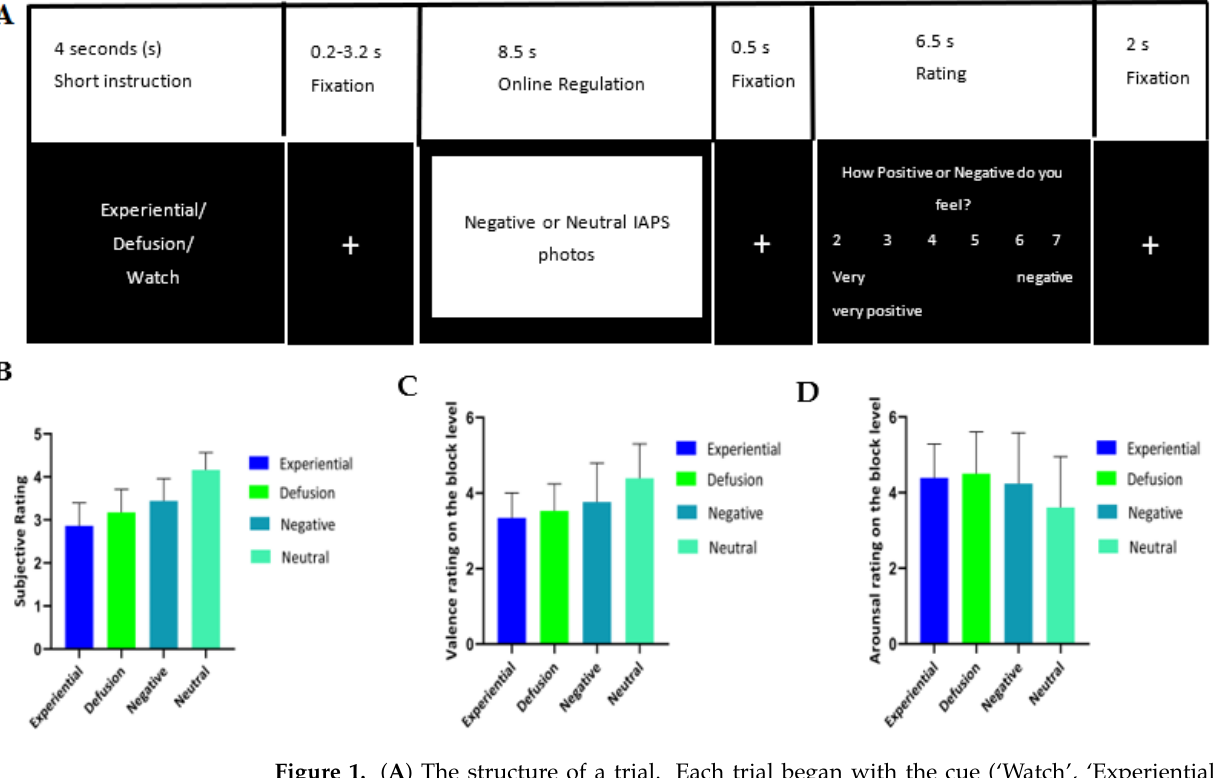
Figure 1. ( A ) The structure of a trial. Each trial began with the cue (‘Watch’, ‘Experiential’, or ‘Defusion’) for each stimulus. Each cue was displayed for 4 s, followed by a 0.2–3.2 s (jittered) interstimulus interval with a white cross and an 8.5 s presentation of a negative or neutral picture. Depending on the cue that preceded the picture, participants were asked to either passively look at the picture (‘Watch’) and actively regulate their emotions by either experiential emotion regulation (‘Experiential’) or by cognitive defusion (‘Defusion’) during the image presentation. Negative photos were shown with either cue, while neutral photos were shown after the ‘Watch’ cue. This resulted in four different blocks in each run: watch negative, watch neutral, experiential emotion regulation ‘negative’, and cognitive defusion ‘negative’. Then, a short white fixation of 0.5 s was presented on the screen. Afterward, subjects had 6.5 s to rate the strength of their negative affect on a scale from 1 (‘very negative’) to 7 (‘very positive’). Finally, a white fixation cross was presented in the center of the screen (2 s), which concluded the trial and functioned as a cool-down period before participants entered the next trial. ( B ) Subjective reports (mean ± standard deviation) on the trial level. ( C ). Valence rating (mean ± standard deviation) on the block level. ( D ). Arousal rating (mean ± standard deviation) on the block level.